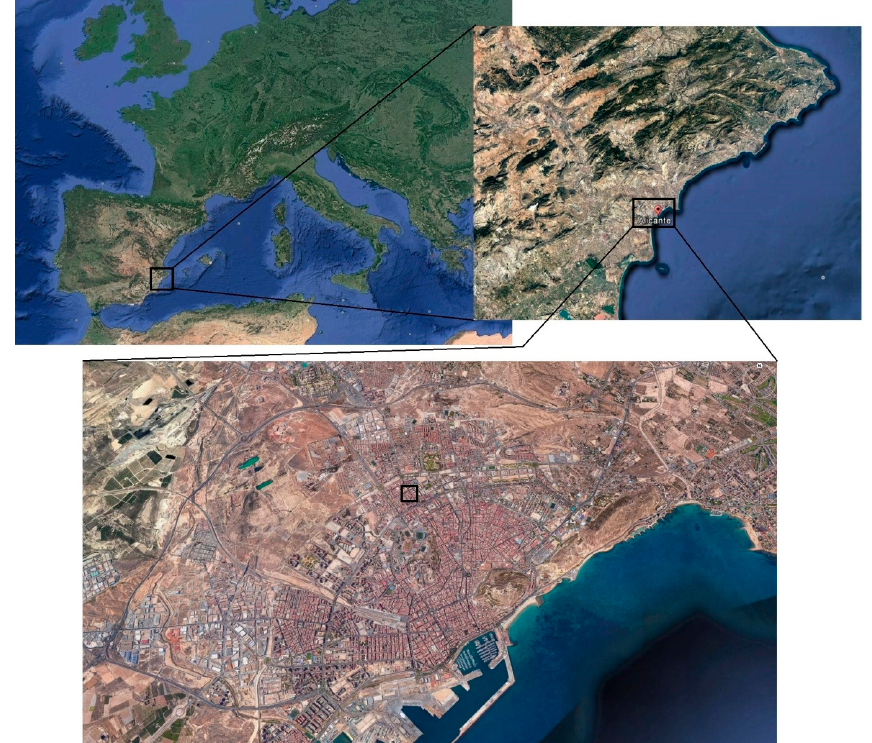
Figure 1. Location of the real exposure site (black line squares). The samples were placed on the flat roof of a building in the city center of Alicante, which is situated in the southeast of Spain. The distance between this exposure site and the Mediterranean Sea coastline was about 2.6 km. The satellite images were obtained using the Google Earth software (Google, CA, USA).